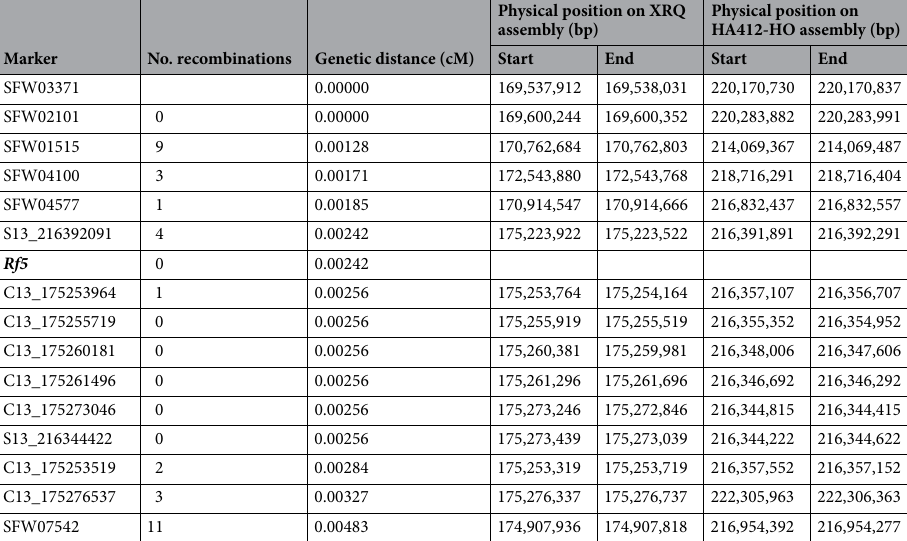
Table 1. Genetic and physical positions of markers linked to Rf5 on the fine map of chromosome 13.